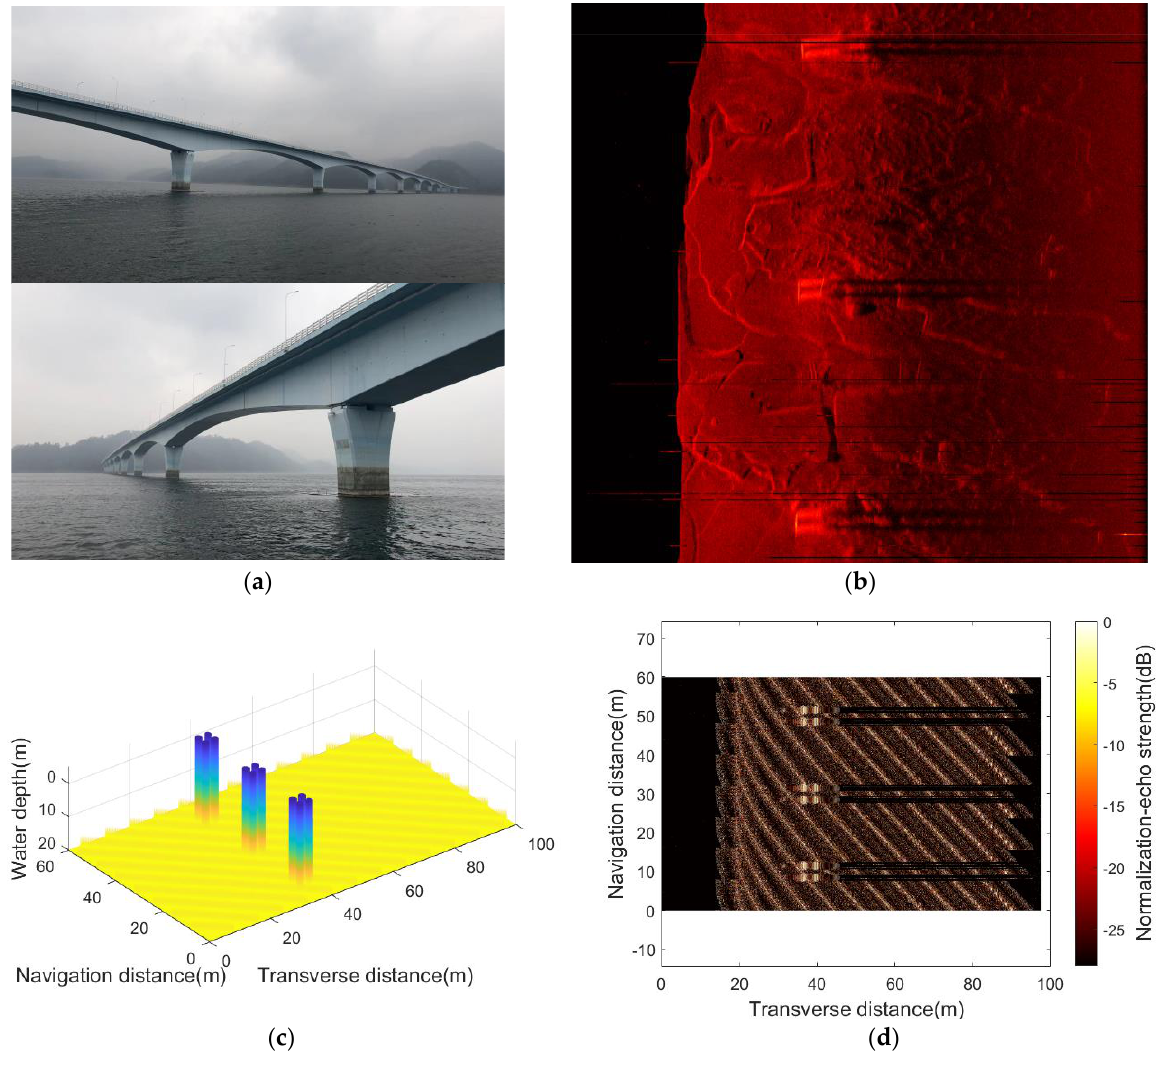
Figure 17. ( a ) Qiandao lake experimental environment in Hangzhou; ( b ) actual mapping results of bridge piers carried out in December 2022; ( c ) virtual experimental environment consisting of bridge piers and lake bottom slash; ( d ) simulation imaging result using the developed sonar simulator.